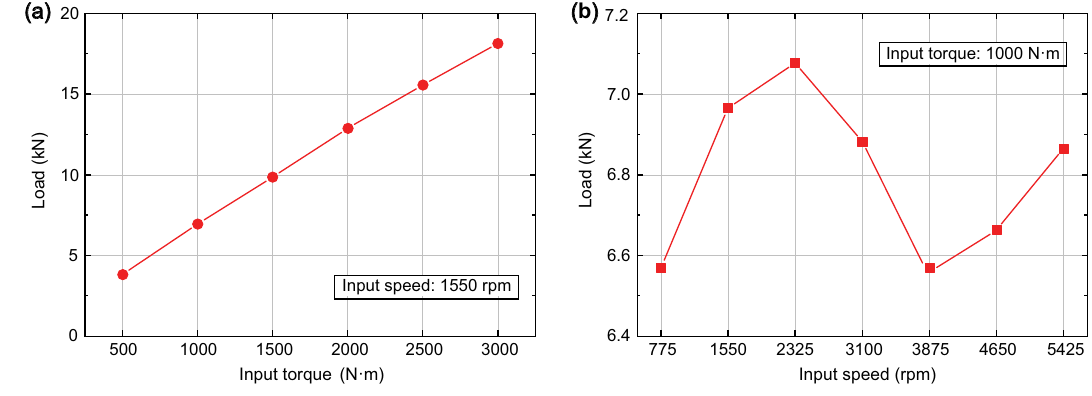
Fig. 11 Mean values of the measured bearing load under conditions of a different torques and b different